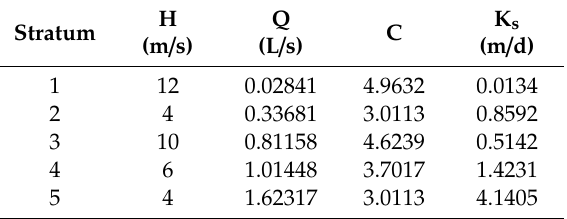
Table 1. Calculation of hydraulic conductivity per stratum, Equation (43).